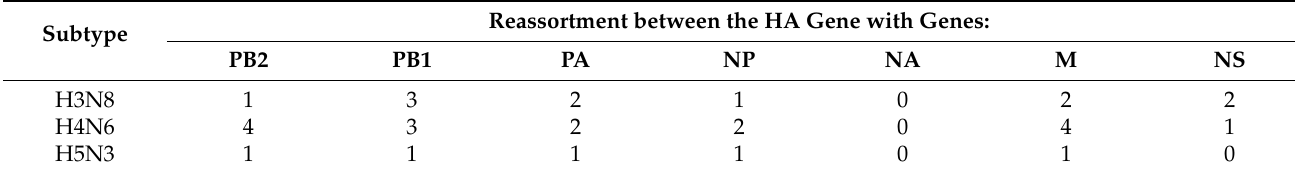
Table 1. Number of interclade reassortments between the HA gene and other genes.